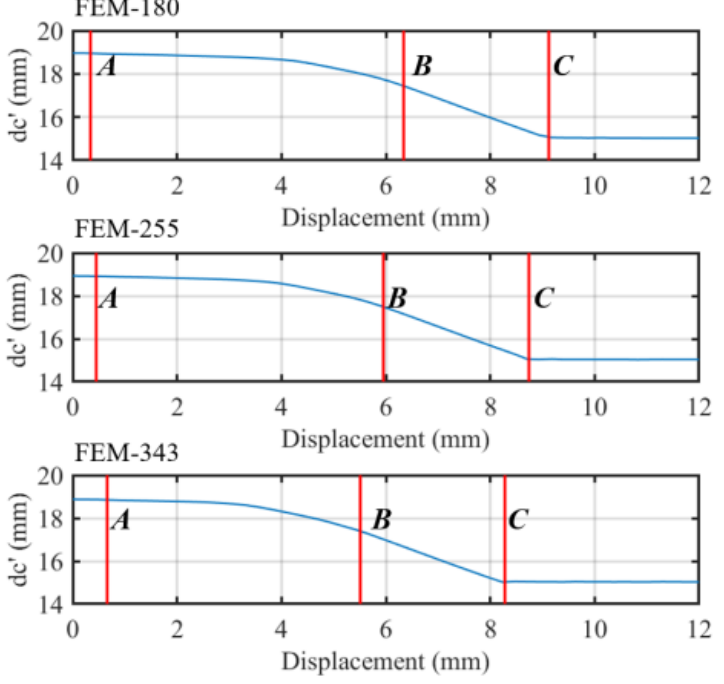
Figure 28. Curve of d (cid:48) c with tensile displacement in the simulation with preload.